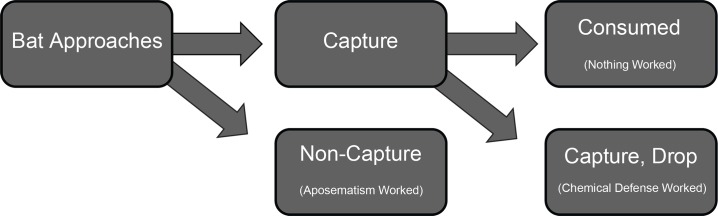
Ethogram showing the progression of bat attacks and possible outcomes of bat-moth interactions.A bat approaches a moth and can either capture or not capture that moth. If the moth is not captured that encounter has ended and the moth has survived. If the bat has captured a moth it can then either drop it or consume it. In this study’s context, if a sound-producing moth is not captured it is evidence that aposematism was effective in deterring the bat attack. If a captured moth is rejected by being dropped they typically survive and this is evidence that defensive chemistry was effective in deterring consumption.